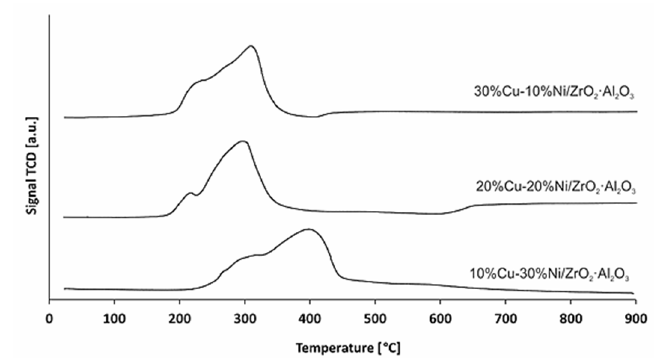
Figure 5. Temperature programmed reduction curves of calcined bimetallic systems (400 °C for 4 h in an air atmosphere) x Cu - y Ni/ZrO 2 ·Al 2 O 3 (where x (y) = 10, 20 and 30 wt.%).